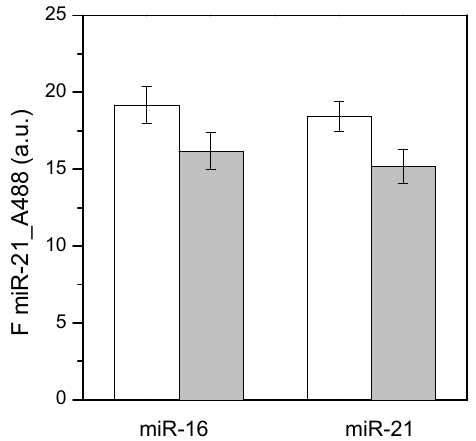
Figure 8. Adsorption (white bars) and elution (gray bars) of synthetic miR-16 or miR-21 fluorescently labeled from surfaces prepared with the 55/10/15 sccm CH 4 /NH 3 /N 2 mixture. Data are means of at least three surfaces. Error bars refer to standard errors ( n ≥